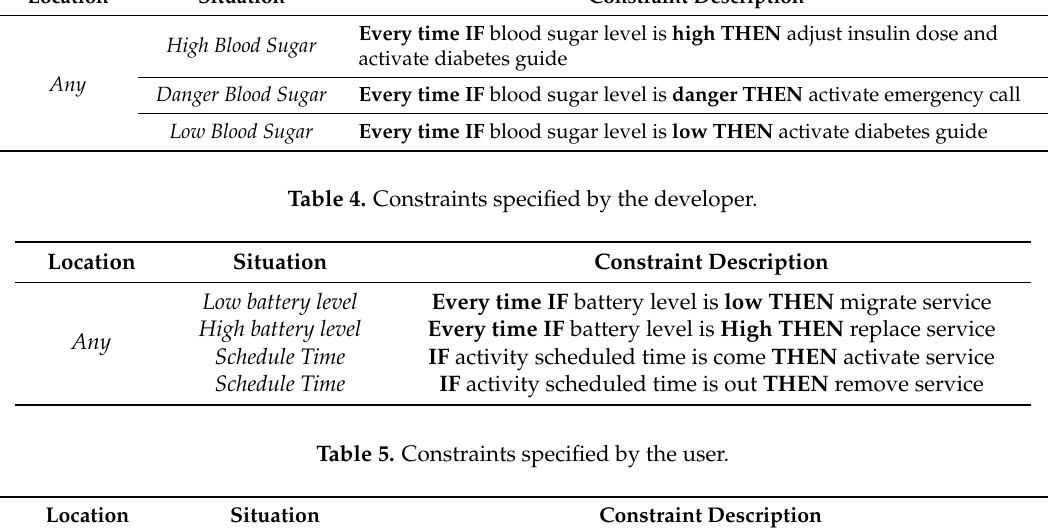
Table 3. Constraints specified by the doctor.